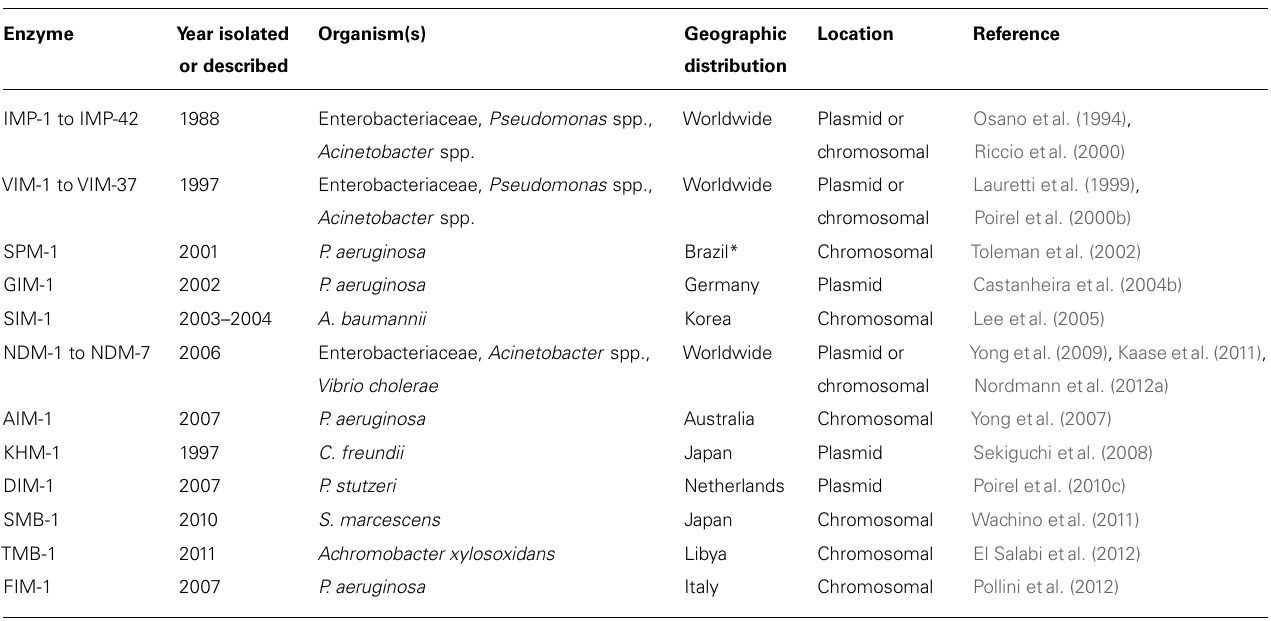
Table 2 | Metallo- β -lactamases.